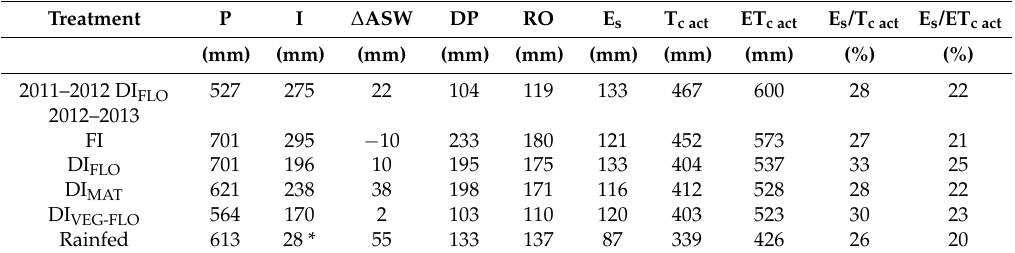
Table 7. Simulated water use components for drip irrigated maize, Paysandú.